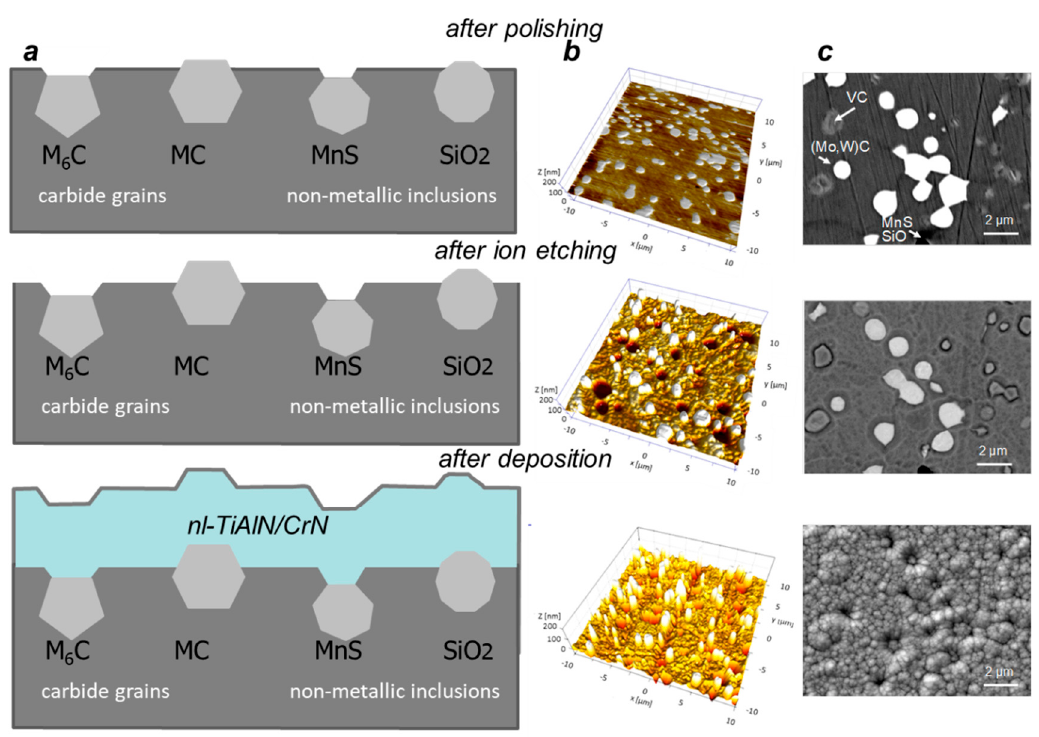
Figure 2. The schemes on the left side ( a ) illustrate the topographical changes of different types of inclusions during various steps of coating preparation (polishing, ion etching, deposition). Atomic force microscopy (AFM) ( b ) and SEM ( c ) images show the topography changes of ASP30 PM steel substrate after polishing, ion etching, and deposition of nl-TiAlN / CrN hard coatings. The SEM images ( c ) were taken at the same site on the substrate surface.